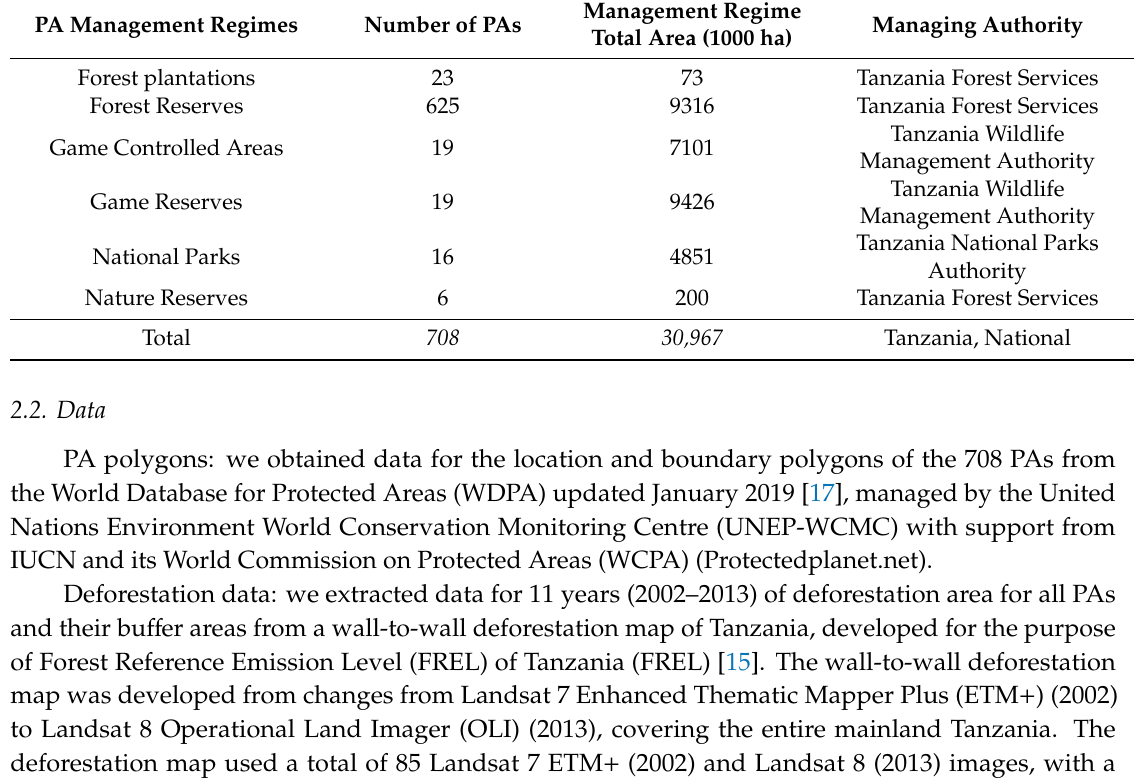
Table 1. Characteristics of the six Protected Area (PA) management regimes in main land Tanzania. PA Management